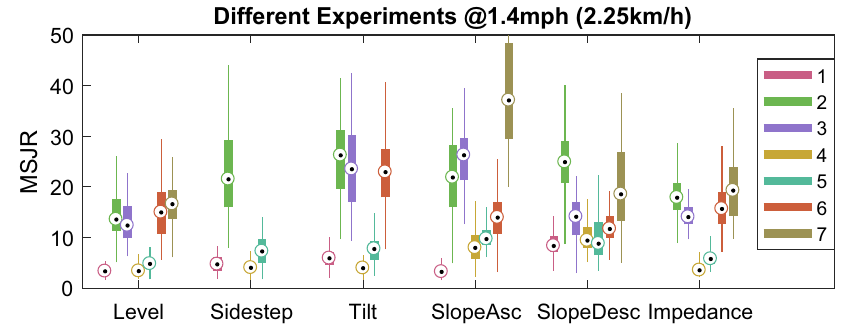
(b) Different experiments at 1.4mph (2 . 25km/h): level walking, level walking with sidesteps, walking on laterally tilted surface (5 ◦ ), on an ascending slope ( + 10 ◦ ), on a descending slope ( 10 ◦ ) and wearing the anklebot with imposed ankle impedance − (stiffness=100Nm/rad, controller damping=0Nms/rad). Missing or noisy data: subjects 3,6,7 for the sidestep experiment; subject 7 for the tilt experiment; and subject 1 for the impedance experiment (see Supplementary Table S1).